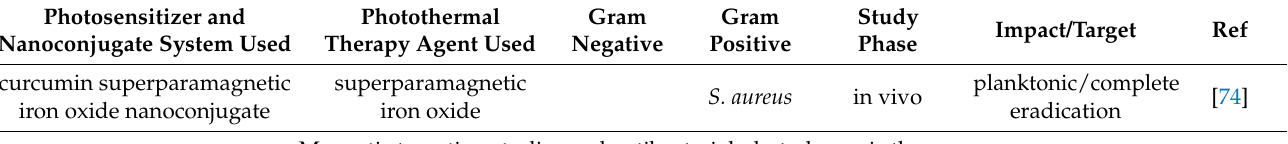
Table 5. Comparative studies of antibacterial photodynamic therapy and magnetic hyperthermia therapy. Photosensitizer